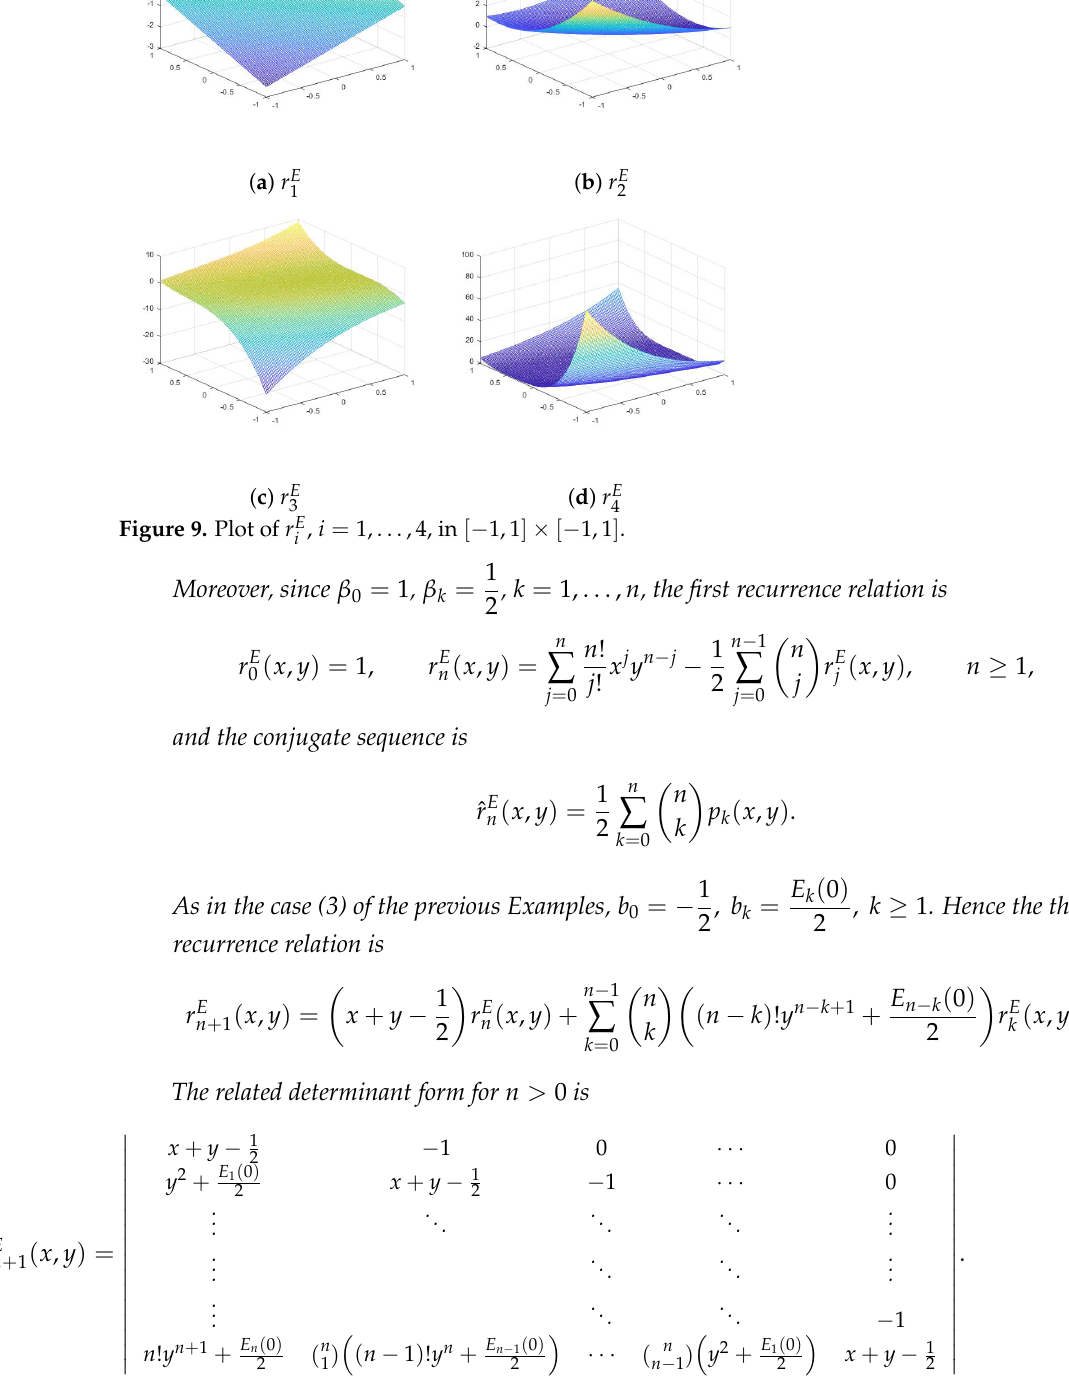
Figure 9. Plot of r E